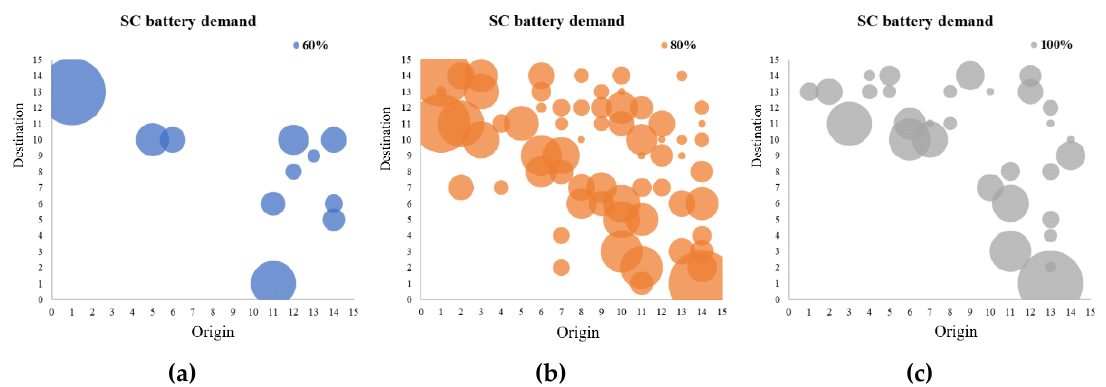
Figure 6. Battery swaps with di ff erent OD pairs with battery SOCs of ( a ) q = 60%; ( b ) q = 80%; and ( c )